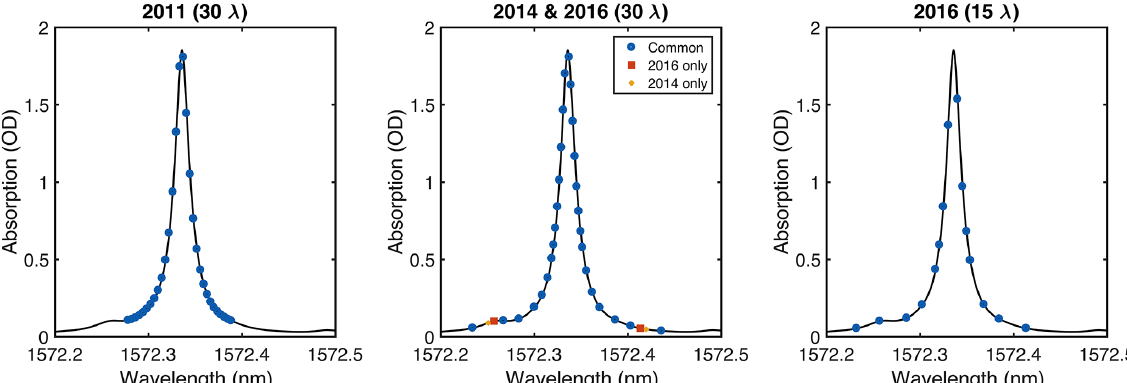
Figure 4. Plots of the CO 2 line sampling laser wavelengths (blue dots) used for the airborne campaigns in 2011, 2014 and 2016. The 2016 campaign used both 30 and 15 laser sampling wavelengths. The CO 2 absorption line shapes (black lines) are shown for a two-way path for airborne lidar measurement conditions from a flight altitude of 13km to a surface elevation of 220m. These conditions occurred during the 3 September 2014 flight over